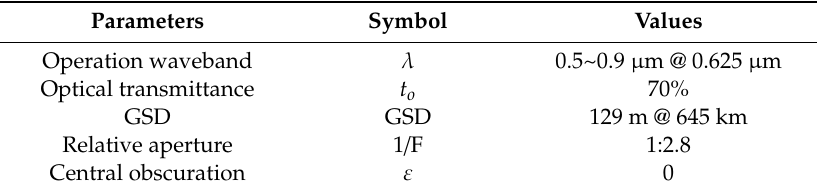
Table 2. Parameters of the Luojia 1-01 satellite.